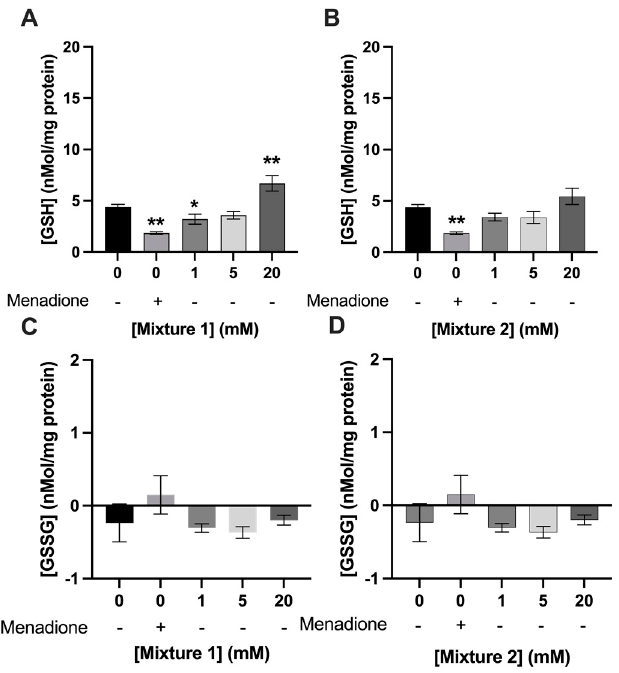
Figure 6. Single SCFAs increased GSH levels in C2C12 myotubes. Menadione (25 µ M) significantly decreased GSH levels in C2C12 myotubes. The SCFAs acetate ( A ), propionate ( B ), and butyrate ( C ) at concentrations ranging from 1–20 mM significantly increased GSH levels in C2C12 myotubes. Menadione, acetate ( D ), propionate ( E ), nor butyrate ( F ) altered GSSG levels significantly compared to control ( N ≥ 4; n = 2). All data are presented as mean ± SEM. * p < 0.05; ** p < 0.01; *** p < 0.001 compared to 0 mM exposure.